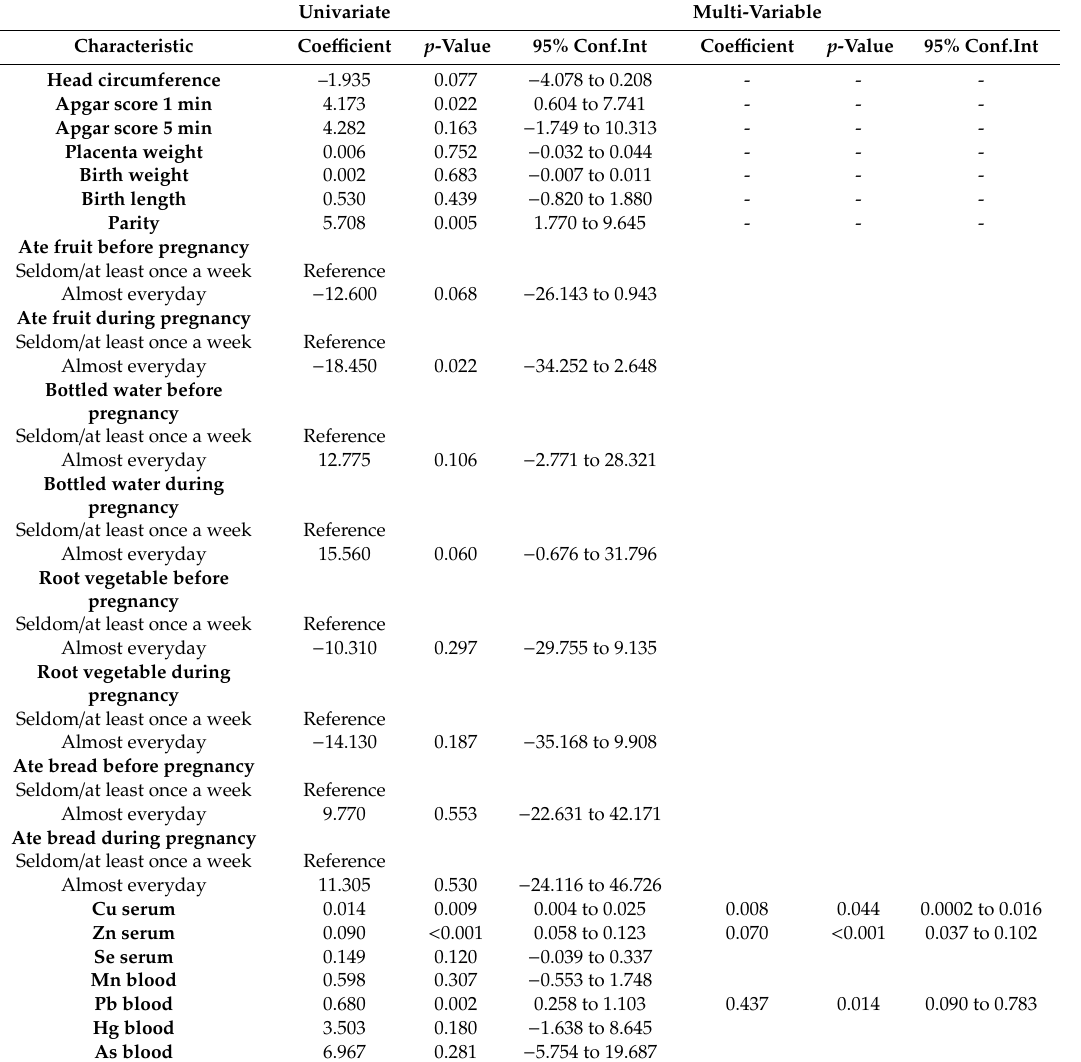
Table 6. Coe ffi cient estimates of quantile regression at 50% quantile-univariate and multi-variable